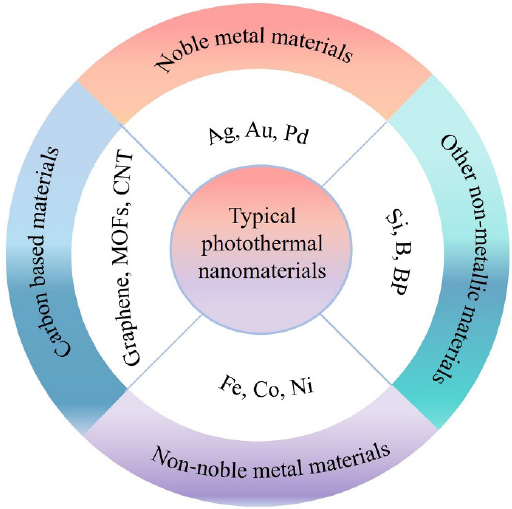
Figure 1. Schematic illustration of typical photothermal nanomaterials.